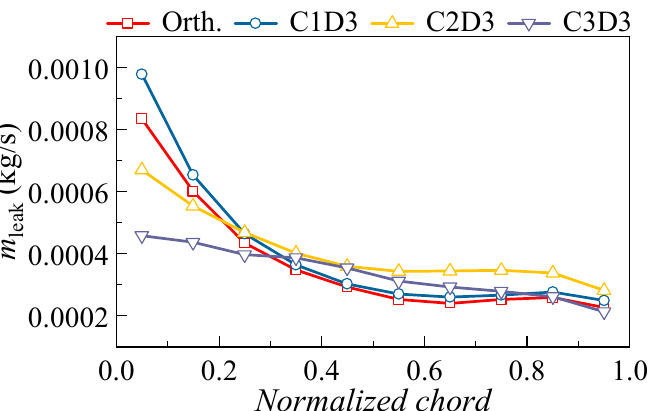
Figure 18. Comparison of the streamwise leakage mass flow rate under different dihedral heights ( φ = 0.46).